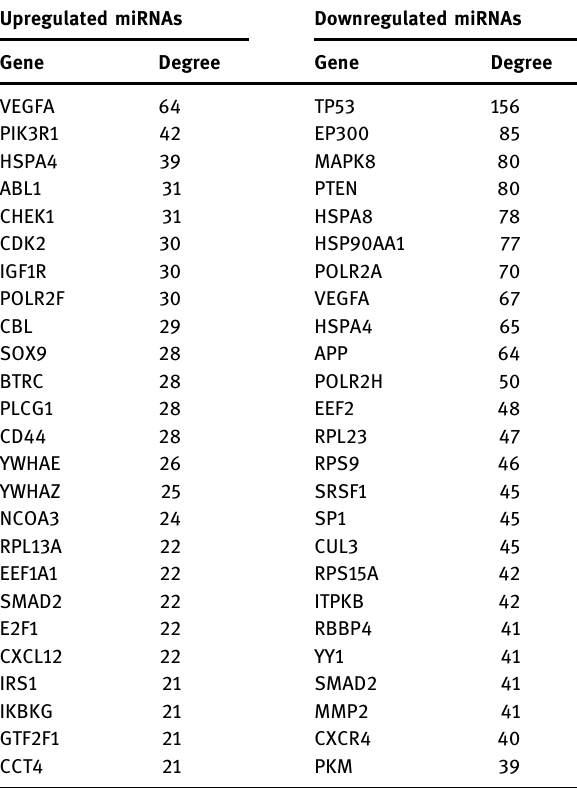
Table 2: Hub genes in the PPI networks Upregulated